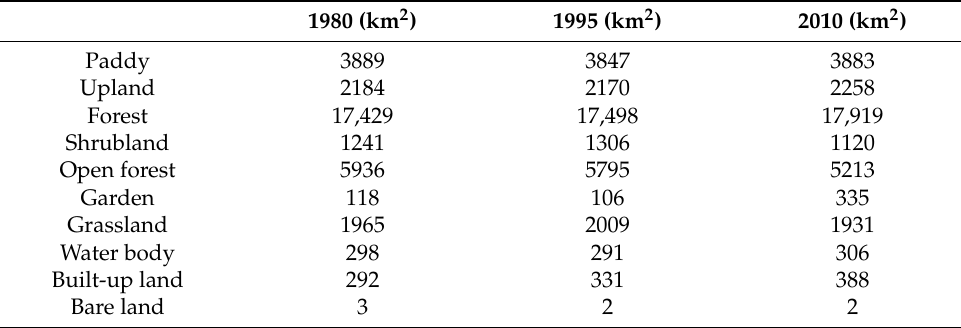
Table 3. Land-use changes in the upper Ganjiang Basin, 1980, 1995, and